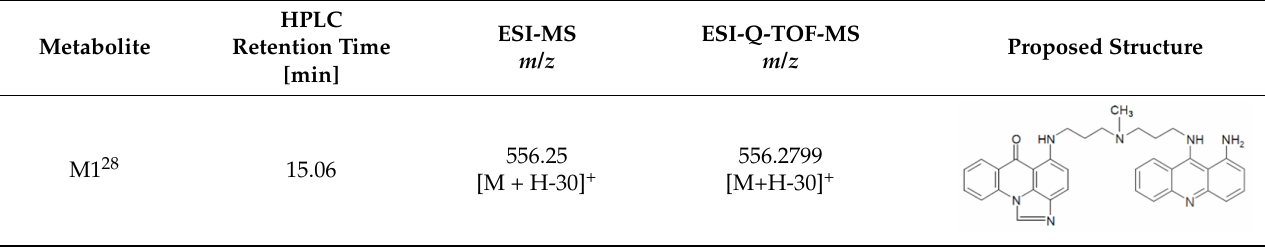
Figure 5. Extracted ion chromatograms of HPLC-MS analysis for all metabolites obtained after 30-min incubations of 0.05 mM ( A ) C-2028, ( B ) C-2045 and ( C ) C-2053 with 1 mg/mL of P4503A4 and P4502C19 isoenzymes. The 2 mM NADPH was applied as the cofactor. Table 3. The structures proposed for main metabolites of UAs formed with P4503A4 and 450P2C19 isoenzymes (1 mg/mL P450 and 2 mM NADPH cofactor) on the basis of their ESI-MS and ESI-Q-TOF-MS (ElectroSpray Ionistaion-Quadrupole- Time of Flight-Mass Spectrometry)